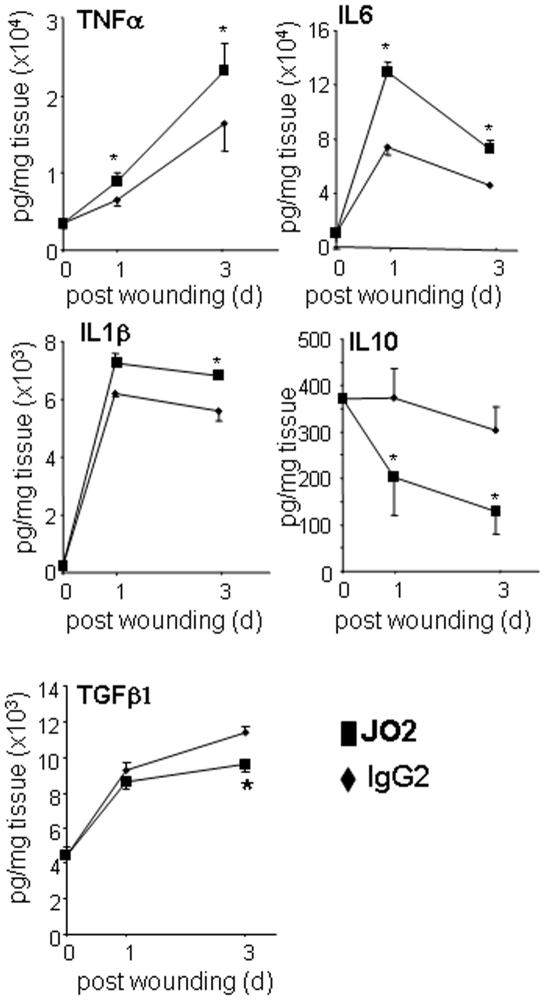
Increasing dead cell burden in wounds resulted in increased pro-inflammatory cytokine levels.Wound tissue treated with anti-CD95 JO2 or control IgG2 were harvested on days 0, 1 and 3 post-wounding. Cytokine levels from paired (control and treated) wound tissue were measured using ELISA on the indicated days post-wounding. Significant increase in pro-inflammatory cytokines (TNFα, IL-6, IL1β) and decrease in levels of anti-inflammatory cytokines IL-10 and TGFβ1 was noted in wounds that had increased apoptotic cell load. Data (mean ±SD, n = 5) are presented as pg cytokine per mg wound tissue. *, p<0.05 compared to IgG treated control side.